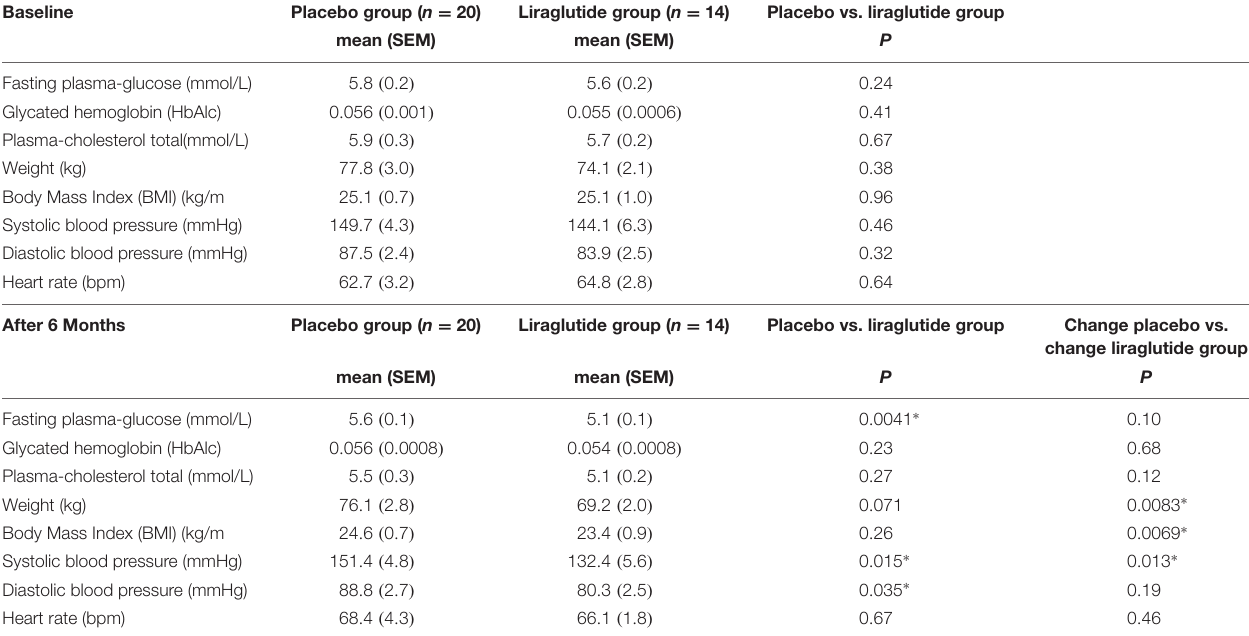
TABLE 3 | Patient